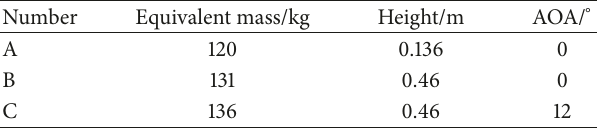
Table 4: Parameters of the drop impact analysis.